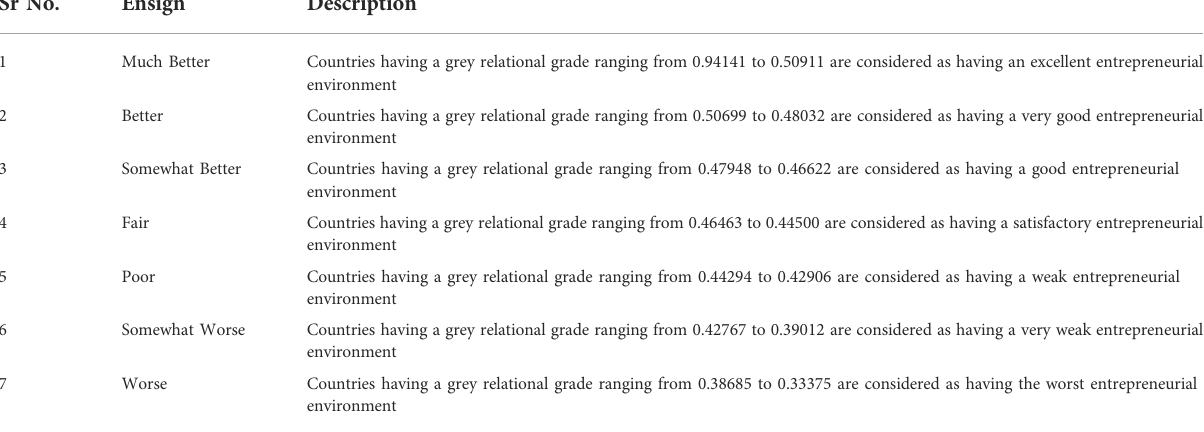
TABLE 8 Scheme of grouping the countries under different ensigns on the basis of grey relational grades. Sr No.